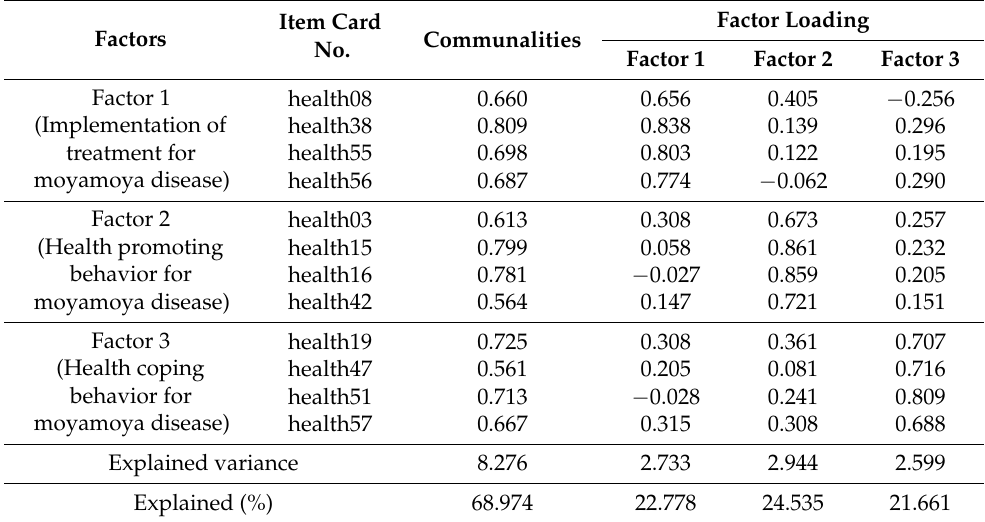
Table 2. Factor Loading of